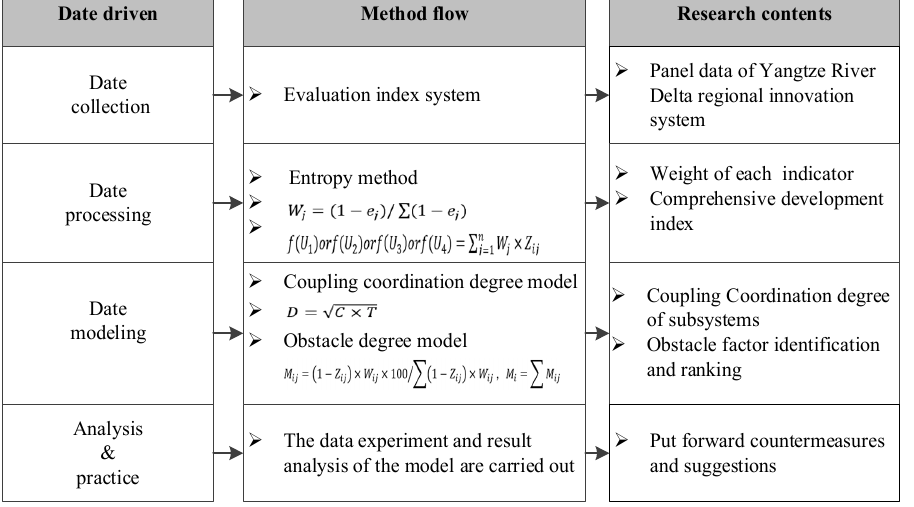
Figure 1. Study method flowchart.